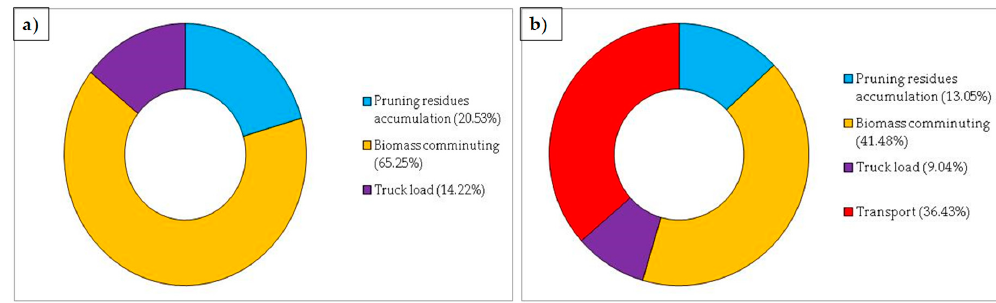
Figure 6. ( a ) Percentage of the total costs for field operations. ( b ) Percentage of the total costs considering also transport operation.